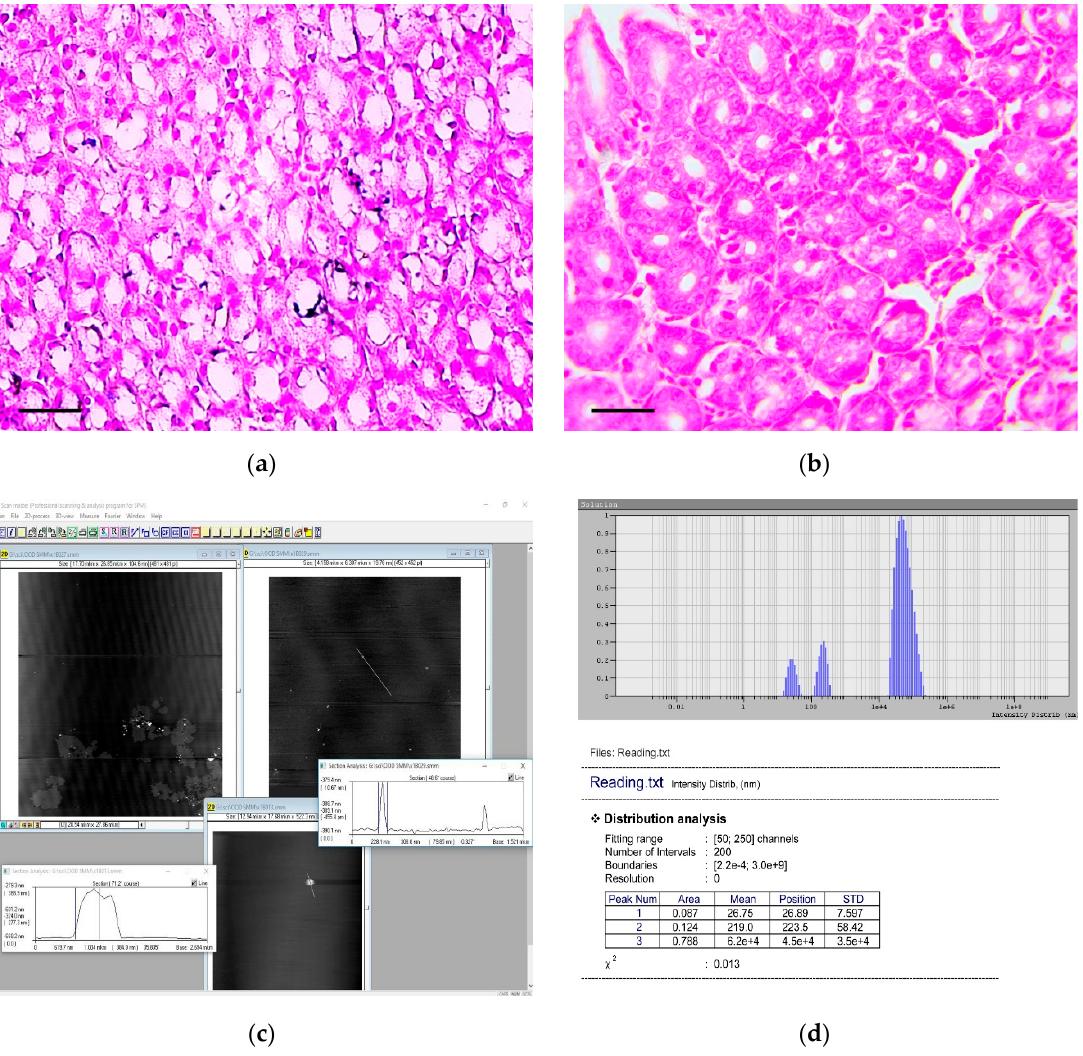
Figure 7. Detection and characterization of calcium carbonate nanoparticles in the carcinogenic suspension and microcalcifications in the gastric mucosa. ( a ) Multiple microcalcifications in the gastric mucosa of experimental rats. von Kossa staining, scale bar 100 µm. ( b ) The absence of microcalcifications in the gastric mucosa of control rats. von Kossa staining, scale bar 100 µm. ( c ) The imaging of aggregates (nanoparticles) obtained by the atomic force microscopy. The scan size is 7.8 × 5.6 µm. ( d ) The histogram of calcium carbonate nanoparticles distribution in carcinogenic suspension according to their hydrodynamic radii, obtained by the dynamic light scattering method.